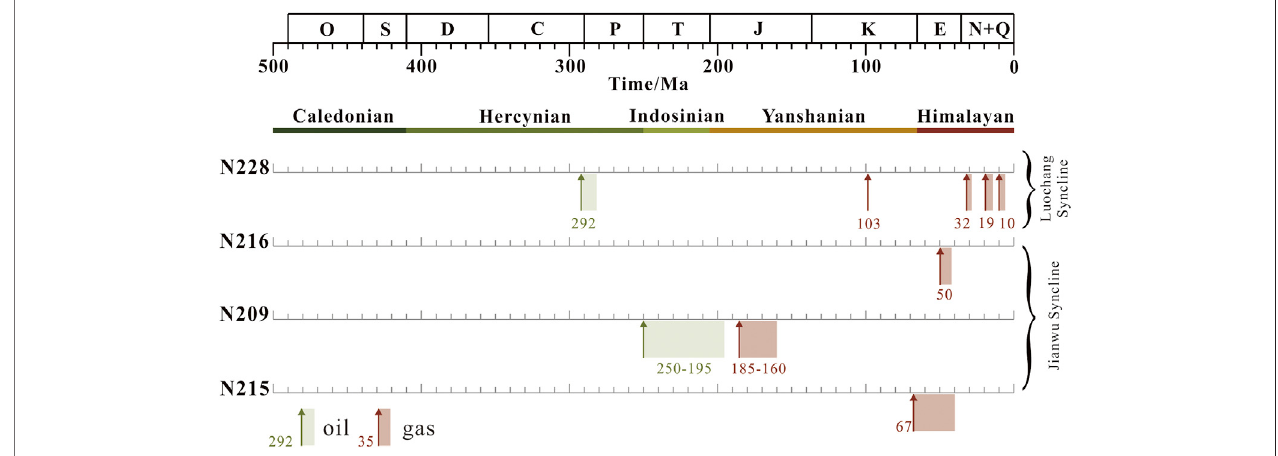
FIGURE 11 | Trapping time of FI of wells N228, N216, N209, and N215 in different synclines of the Changning area, southern Sichuan Basin. The data of wells N209, N215, and N216 collected by Gong (2019) and Liang et al. (2021).